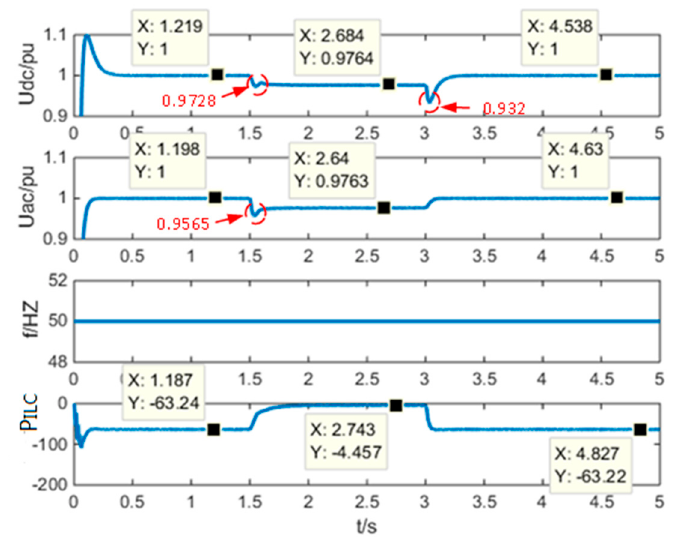
Figure 17. DC voltage, AC voltage, frequency, and ILC transmission power (DC load = 112.5 kW; AC load = 75 kW).